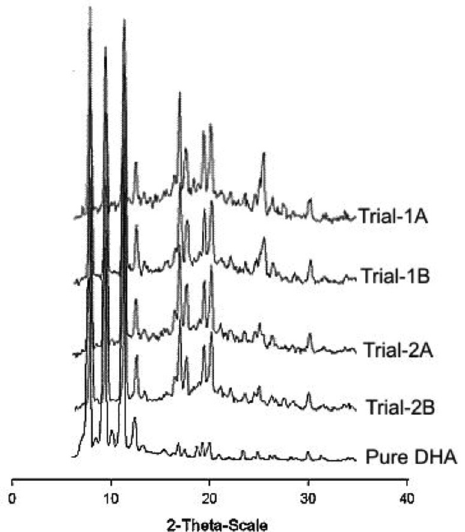
FIGURE 6 - XRD comparison of pure DHA and DHA